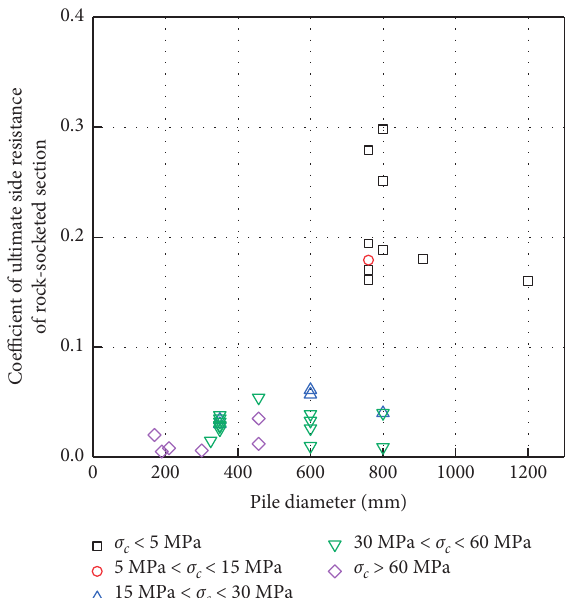
Figure 6: Relationship between pile diameter and coefficient of ultimate side resistance of rock-socketed section.